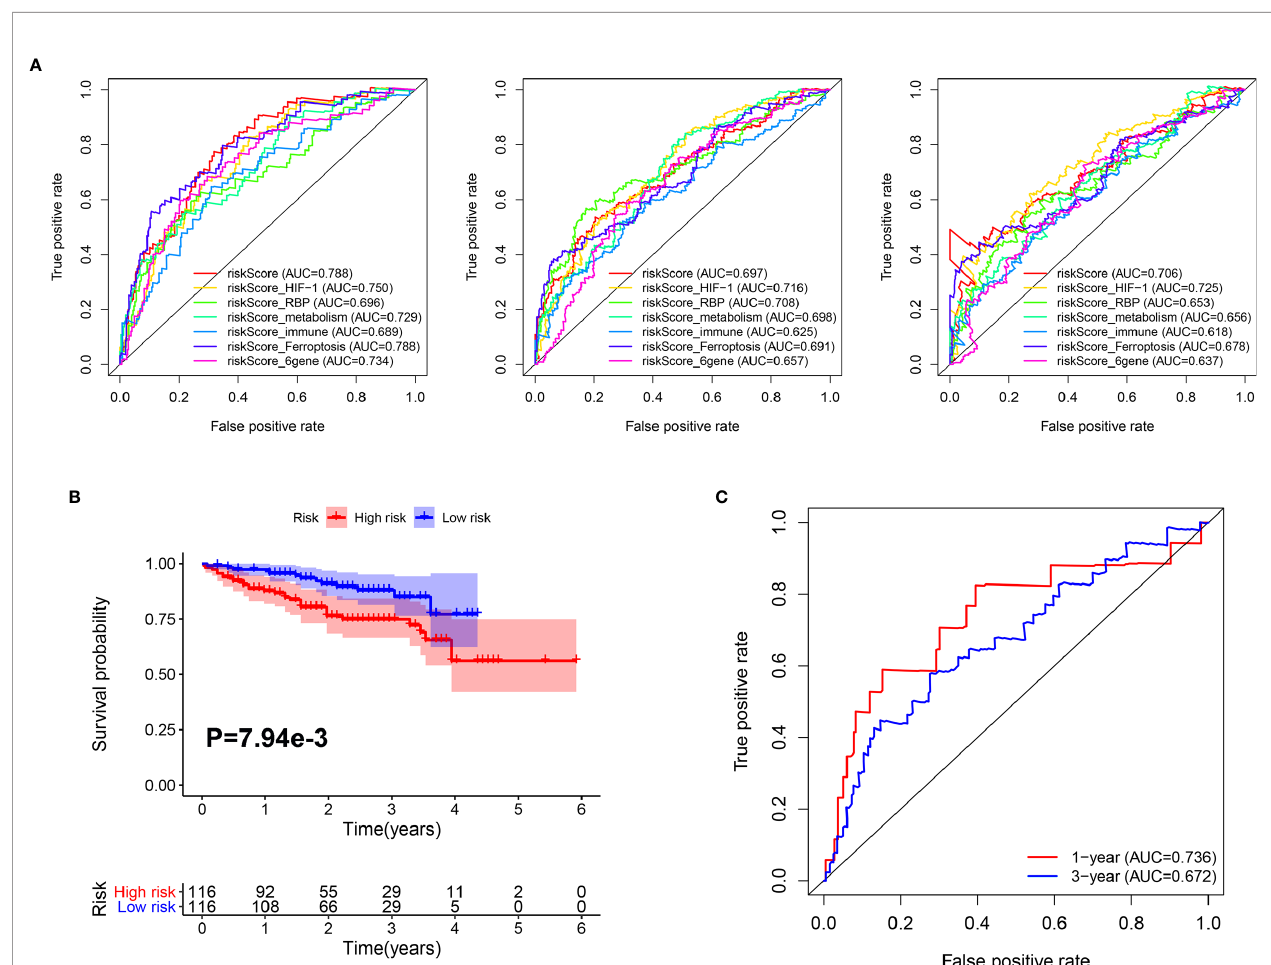
FIGURE 6 | Comparison and validation of the prognostic value of the Mito-RG-based classi fi er. (A) The time-dependent ROC for 1-, 3-, and 5-year overall survival predictions for the classi fi er in comparison with other classi fi ers. (B) Kaplan-Meier analysis of overall survival between high and low-risk patients from ICGC cohorts. (C) The time-dependent ROC for 1- and 3-year overall survival predictions for the classi fi er in ICGC